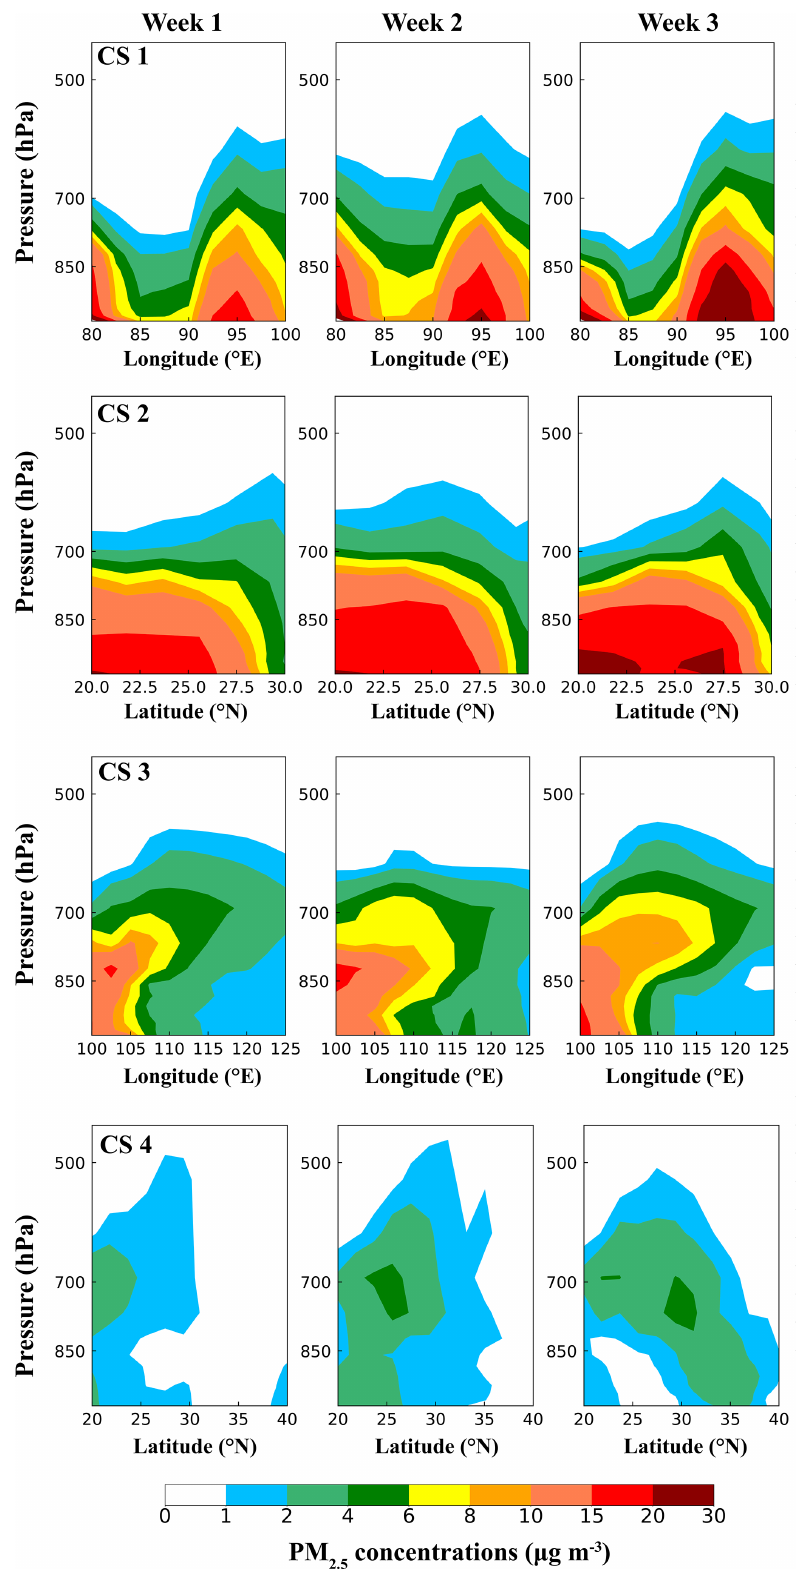
Figure 4. Vertical distributions of PM 2 . 5 concentrations (µgm − 3 ) originating from emissions outside China (i.e., ROW sources) across the latitudinal and/or longitudinal extents marked in Fig. 1, respectively, during the three time periods.